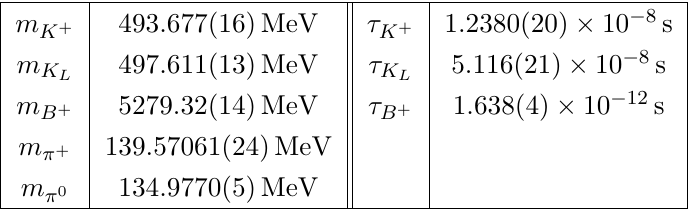
Table 2 . The input parameters we used